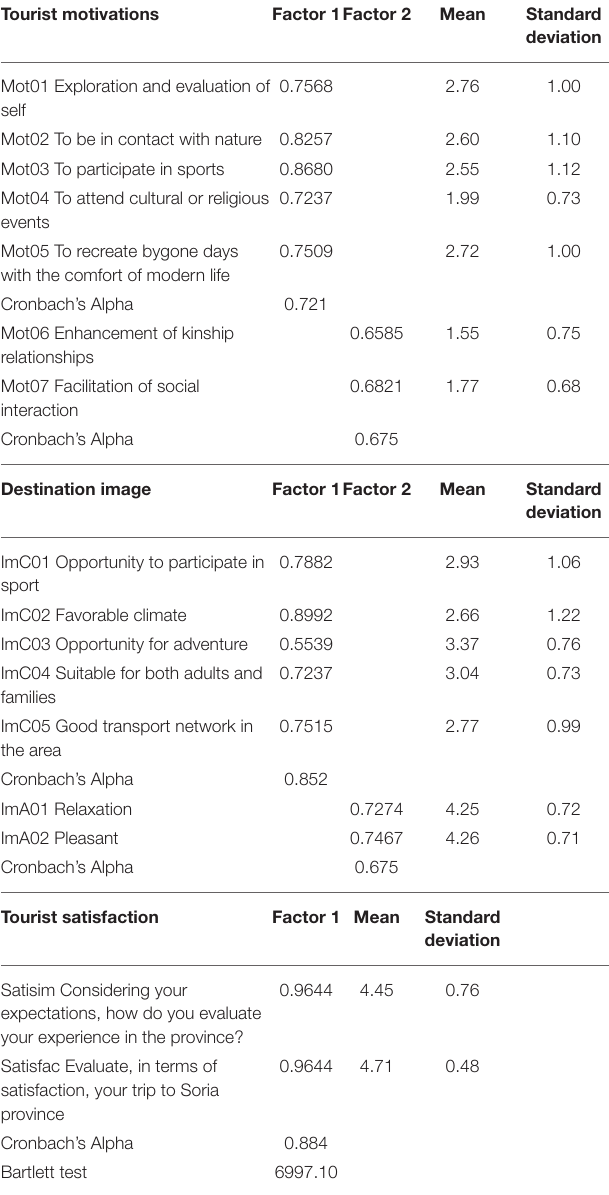
TABLE 4 | Rotated components matrix (Varimax